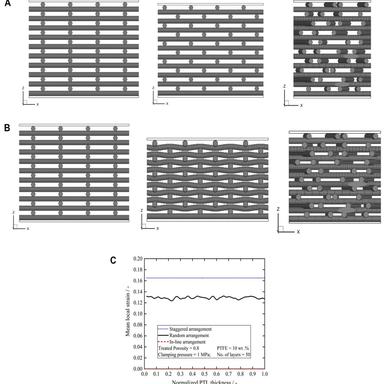
Lateral views of the three different fiber arrangements (a) before and (b) after the external stack compression, and (c) local strain variations through the normalized domain thickness for three different fiber arrangements.